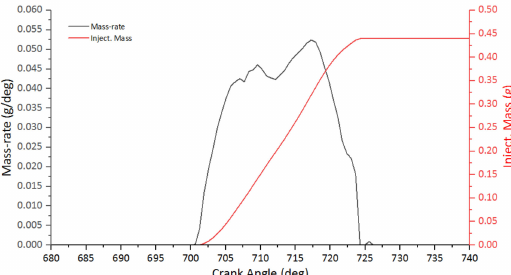
Figure 5. Curves of fuel injection rate and cumulative injection mass.